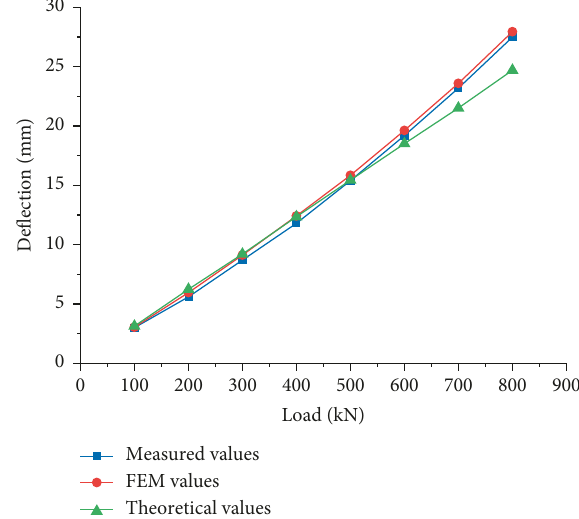
Figure 12: Load-maximum vertical deflection curve of composite beam. The measured value was obtained by analyzing the measured data of the sensors. The FEM value was obtained by the finite element method. The theoretical value was obtained by the the- oretical formulas of composite beam with UDS in Section 2.1.